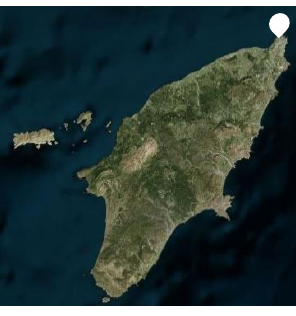
Figure 1: Location of the acropolis of Rhodes on the map of Rhodes Island